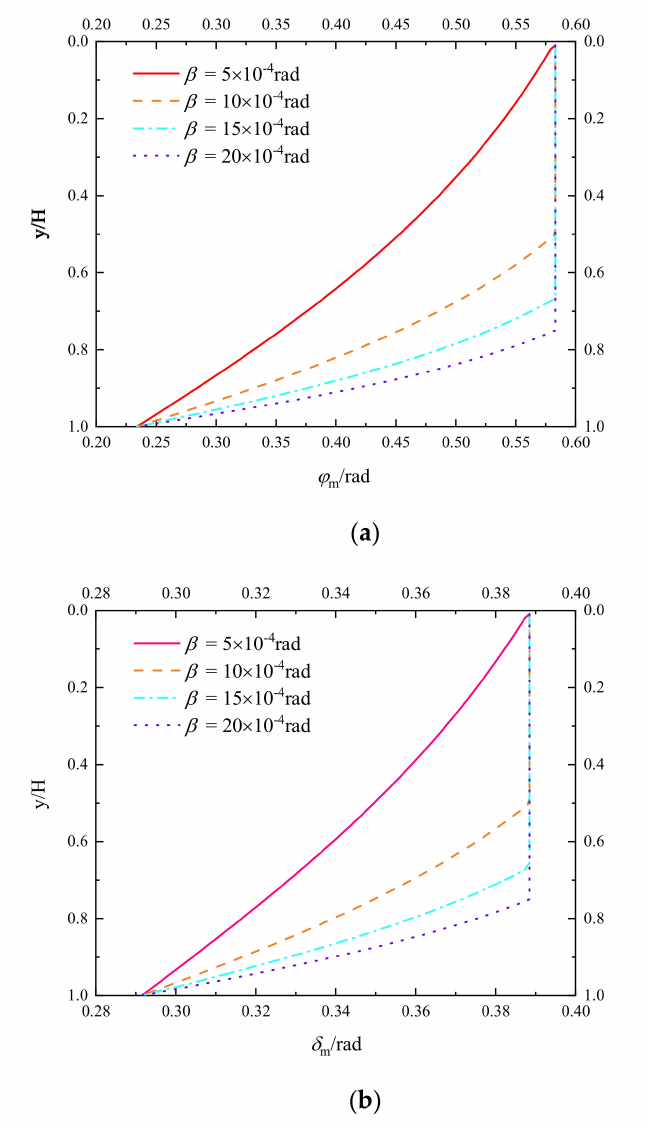
Figure 8. Effect of rotation angles on the effective value distribution along wall depth of ( a ) soil friction angle ϕ m and ( b ) interface friction angle δ m